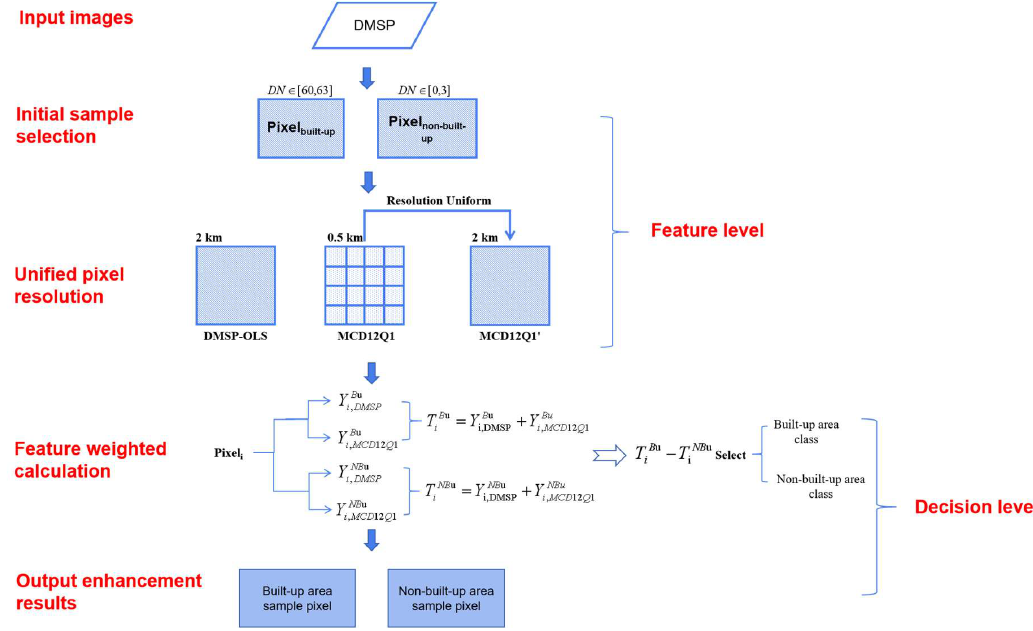
Figure 3. Flowchart of multi-level Data Fusion.